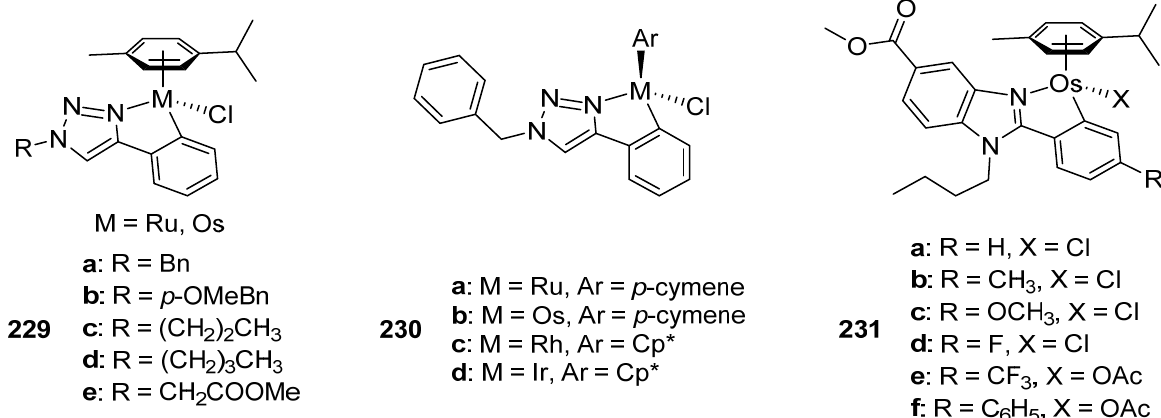
Figure 57. Complexes tested against various human cancer cell lines.